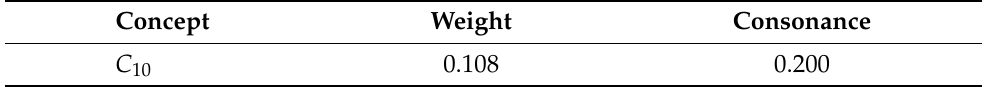
Table 7. Vector of positive–negative changes in concept C 10 .